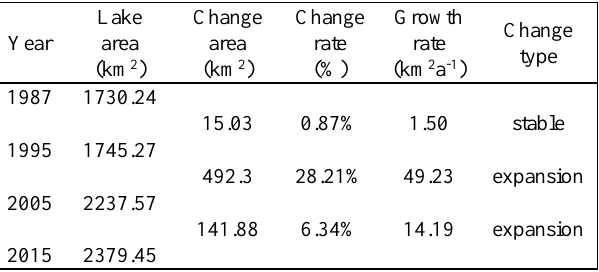
Table 4. Selin Co area changes from 1995 to 2015